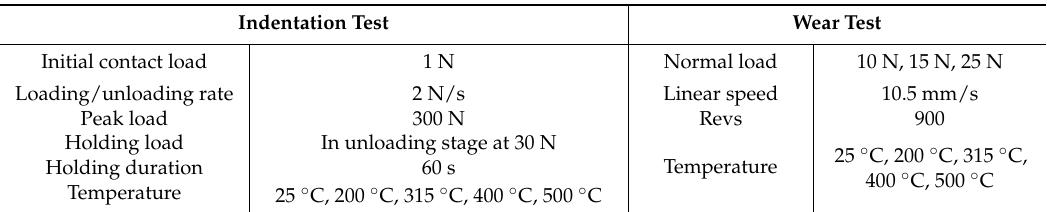
Table 1. Parameters used in high temperature indentation tests and wear